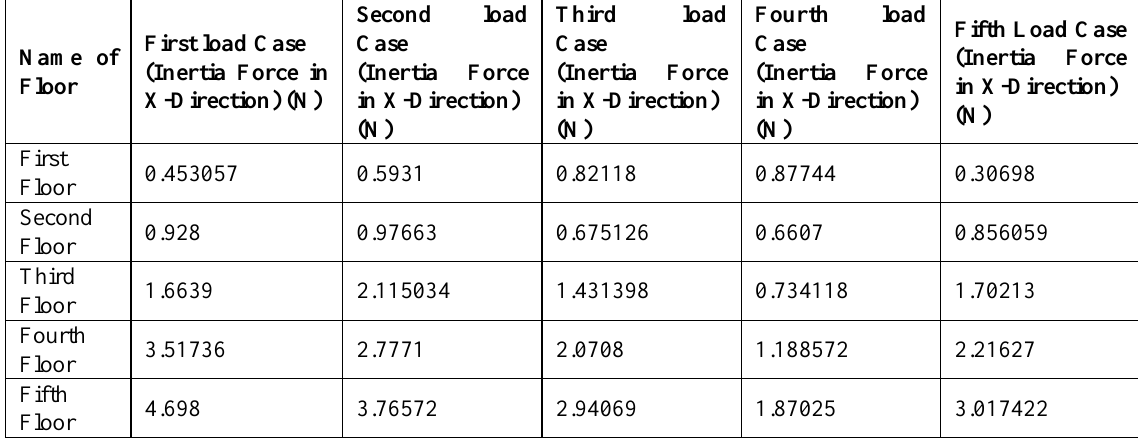
Inertia force results.